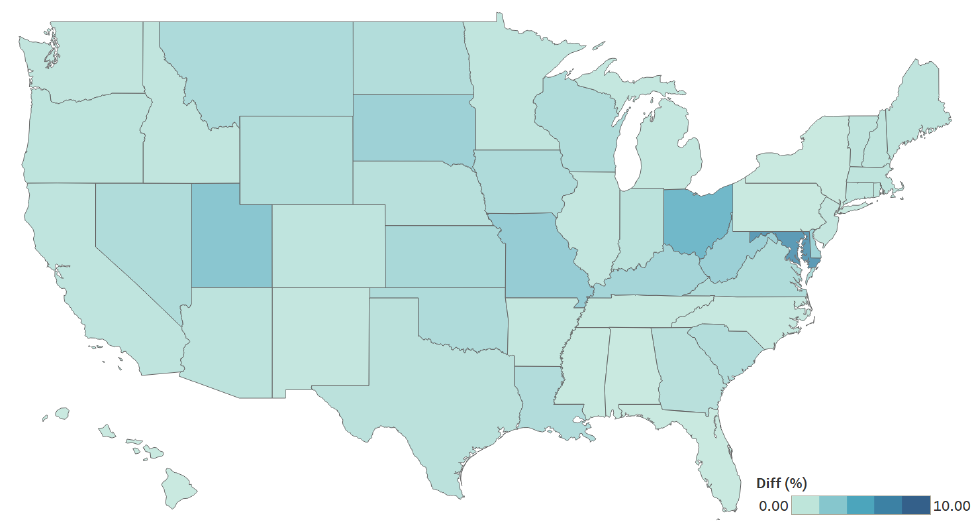
Figure 6. Absolute relative differences (%) between state-level survey and model point estimates for the average wage rates of all hired agricultural workers.